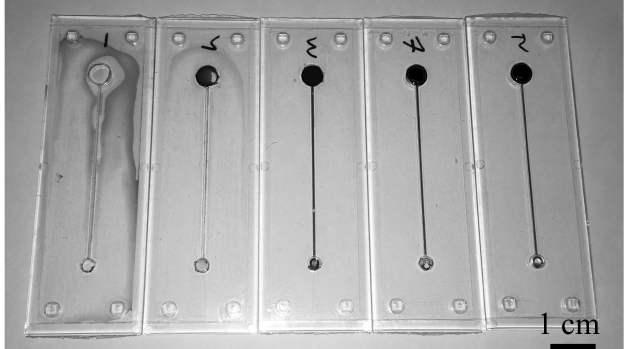
Figure 6. Sealing test results of products bonded at different bonding pressures of 0.1 MPa, 0.5 MPa, 1.0 MPa, 1.5 MPa, and 2.0 MPa (from the left to right). The bonding temperature is 95 ◦ C. Dyed water is injected through the upper chamber to visualize the